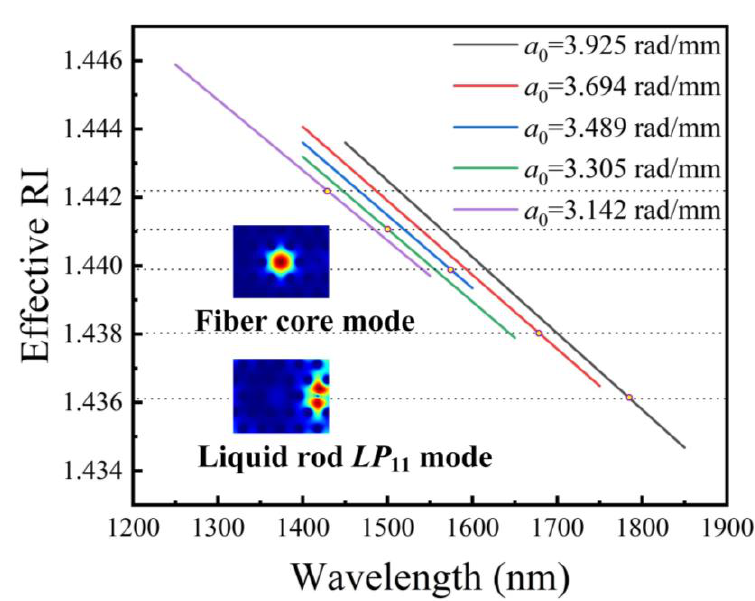
Figure 2. Dispersion curves of liquid waveguide LP 11 modes in LFTPCFs with different α 0 . The yellow points identify phase-matching points between the core mode and the liquid waveguide LP 11 mode under various α 0 , respectively.